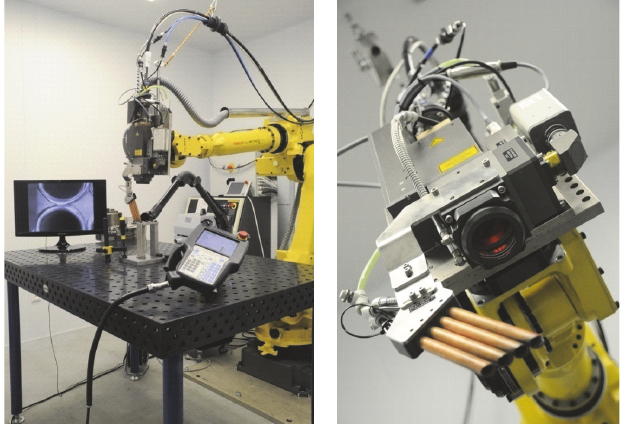
Figure 6: Laboratory of laser beam welding at the Faculty of Materials Science and Technology of STU in Trnava: (a) laser workplace with 6-axis robot FANUC M-710iC/50 and (b) detail of BEO D70 focusing